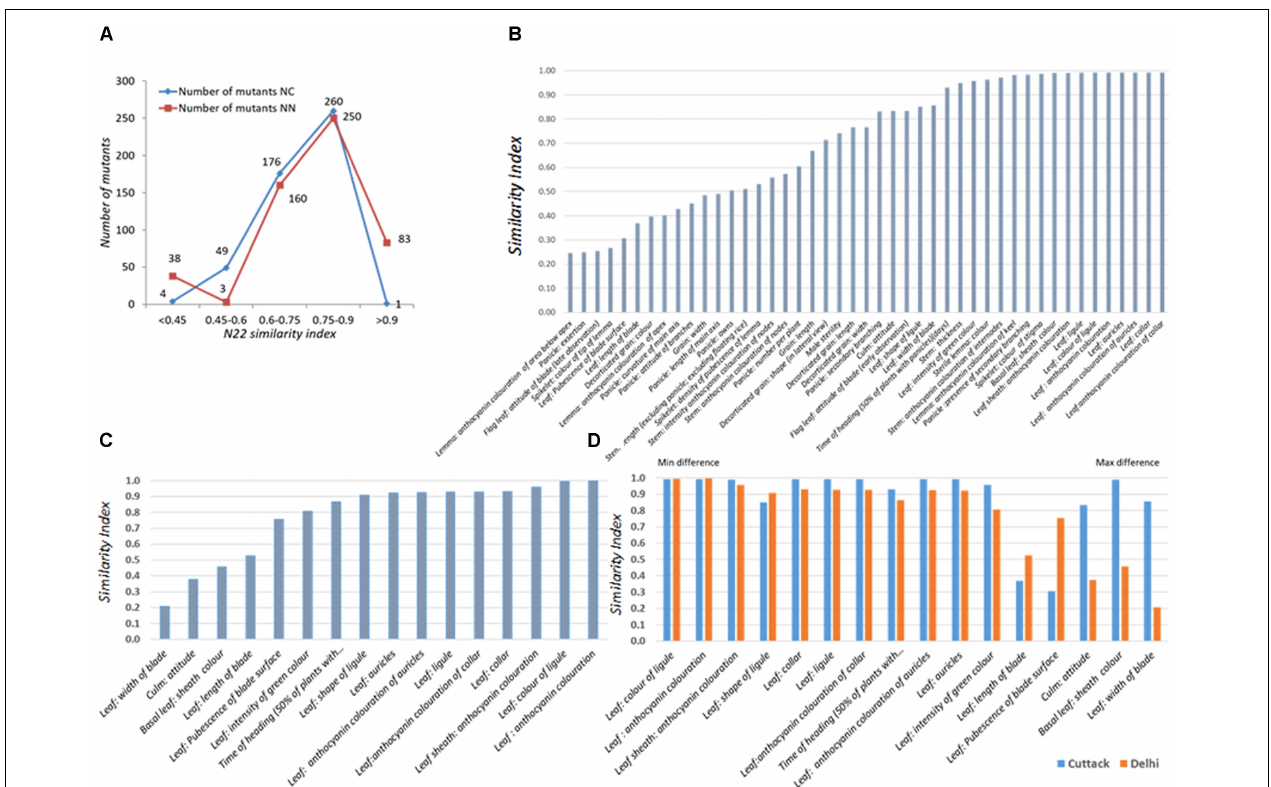
FIGURE 2 | Performance of the rice EMS mutants of Nagina 22 for DUS across two locations, (A) Distribution of similarity index of mutants in two locations, New Delhi (NN) and Cuttack (NC); (B) Traitwise similarity index at NC; (C) Traitwise similarity index at NN; (D) Comparison of traitwise similarity index at NC and NN. Similarity scores were assigned by comparing the mutant trait value with the WT trait value. If they are same, a score “1” was assigned; if not “0” score was assigned. The scores were averaged across all the traits to arrive at mutant similarity index. The scores were also averaged over all the mutants for each trait to arrive at trait similarity